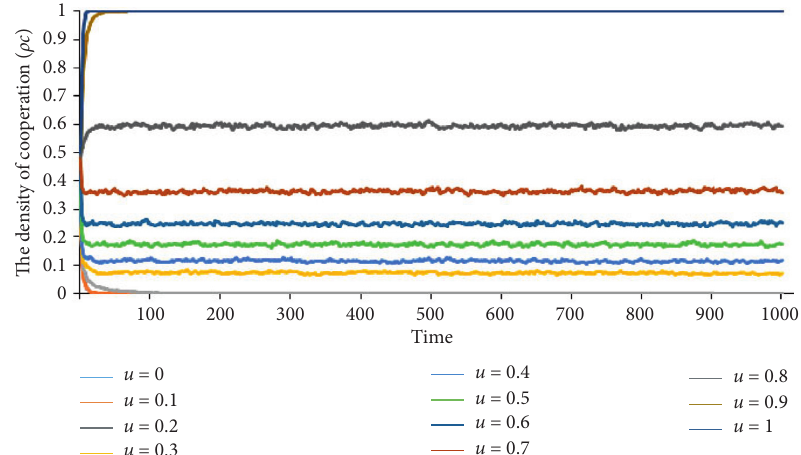
Figure 4: Time course of the density of cooperation for different values of u , the depicted is obtained in SDG for α � 0 and r � 0.8. It is observed that the density of cooperation will rise with the increase of u .